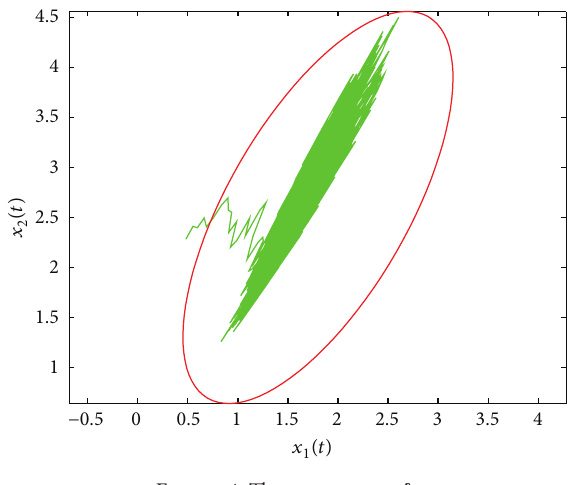
Figure 4: The attractor set A